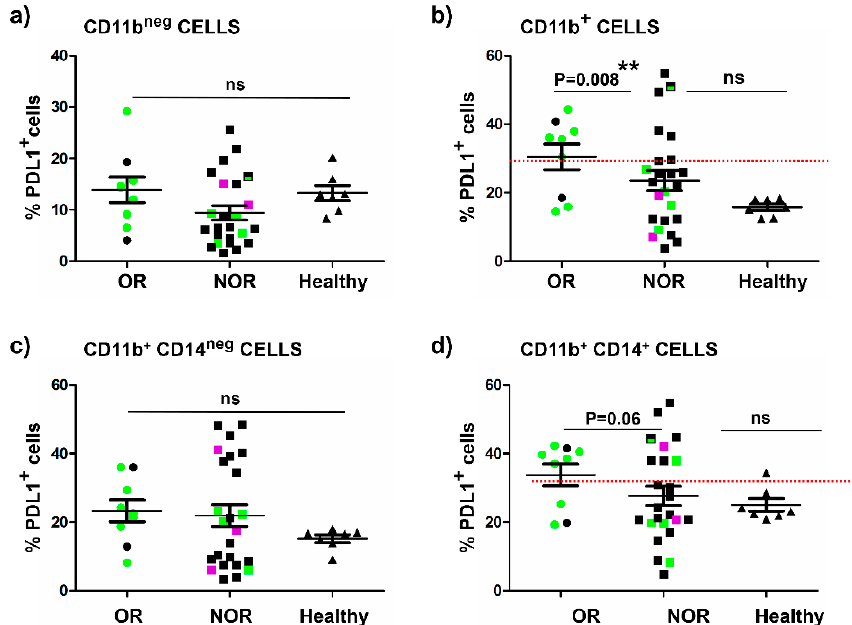
Figure 4. Quantification of PD-L1 + cell subsets in different compartments of immune cell types in peripheral blood and correlation with clinical responses. ( a ) Dot plot graph representing the percentage of PD-L1 + cells within systemic CD11b negative subsets quantified from fresh peripheral blood samples before the start of immunotherapies, in objective responders (OR, N = 9), non-responders (NOR, N = 24), and healthy donors (N = 7). ( b ) Within CD11b + cell subsets. ( c ) Within CD11b + CD14 negative subsets. ( d ) Within CD11b+ CD14+ subsets. Relevant statistical comparisons are indicated within each graph, by the Fisher’s exact test, considering as cut-off values the indicated with horizontal red dotted lines. Means ± standard deviations are shown within the dot plots. Green, patients with >40% of systemic memory CD4 T cells; Black, patients with <40% of systemic memory CD4 T cells; Violet, patients with stable disease.